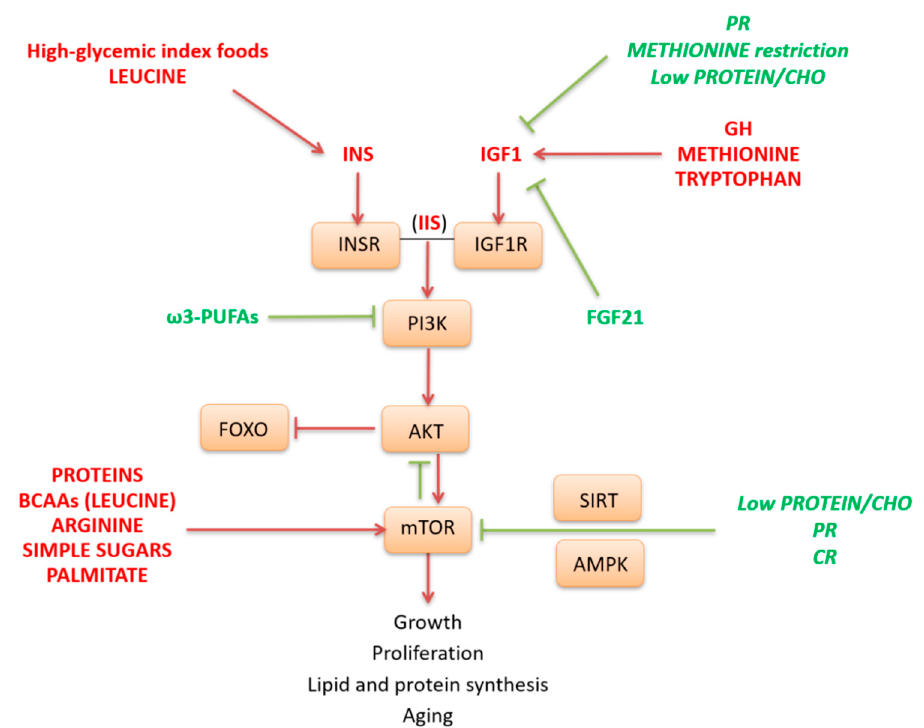
Figure 2. Specific nutrients and dietary manipulations a ff ecting insulin / insulin-like growth factor signaling (IIS) pathway. IIS pathway activates the kinase mammalian target of rapamycin (mTOR) and promotes growth and aging. High-glycemic index foods as well as high intake of some amino acids (AAs) like leucine are the dietary components most involved in increasing insulin levels after feeding. Other AAs like methionine and tryptophan act on growth hormone-insulin-like growth factor 1 (GH-IGF1) pathway. Moreover, the downstream e ff ector mTOR is directly stimulated by specific AAs including leucine and arginine, simple carbohydrates like glucose and fructose, and saturated fatty acids like palmitate. Other nutritional conditions suppress IIS pathway. In particular, this pathway is downregulated by caloric restriction (CR), protein restriction (PR) and by diets having a low ratio between proteins and carbohydrates (CHO), as well as by the stress-responsive hormone fibroblast growth factor 21 (FGF21). Other nutrients such as ω 3-polyunsaturated fatty acids ( ω 3-PUFAs) cause mTOR repression by acting as negative modulators of fosfoinositide 3-chinasi (PI3K) / AKT pathway. Inhibition of mTOR may be also induced by CR, PR and low protein / CHO diets through mechanisms involving AMP-activated protein kinase (AMPK) and sirtuin (SIRT) activation.